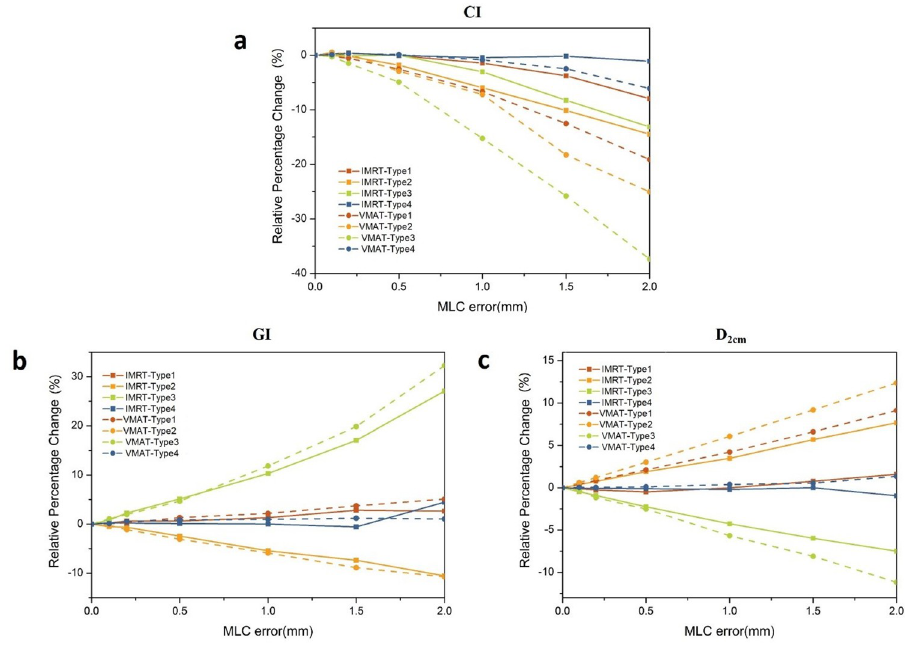
Fig 3. The percentage changes for CI, GI, and D2cm for all types of MLC position errors in IMRT plans and VMAT plans. 3(a) CI decreased with increasing MLC error; 3(b) the relative percentage change of GI compared to each type of MLC error; 3(c) the relative percentage change of D 2cm compared to each type of MLC error.